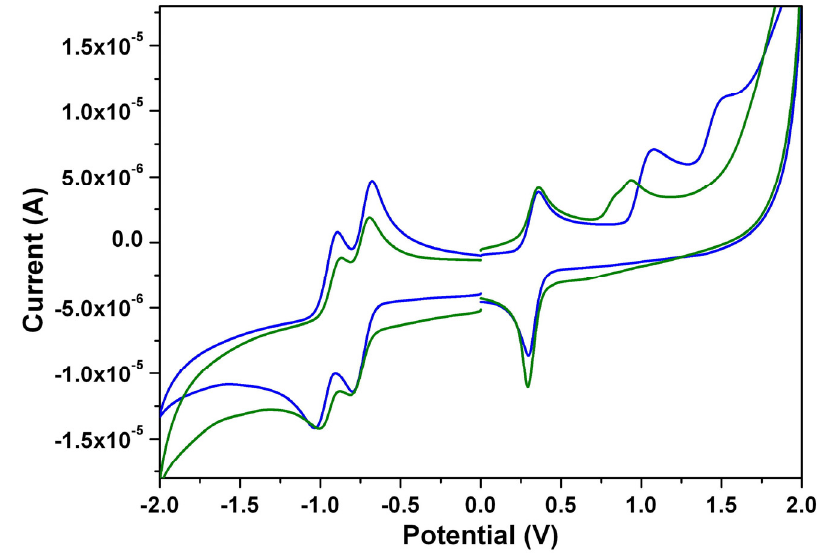
Figure 9. The cyclic voltammograms of 1a (olive line) and 2a (blue line) measured in dichloromethane solution with ferrocenium/ferrocene as an internal standard, at 200 mV·s − 1